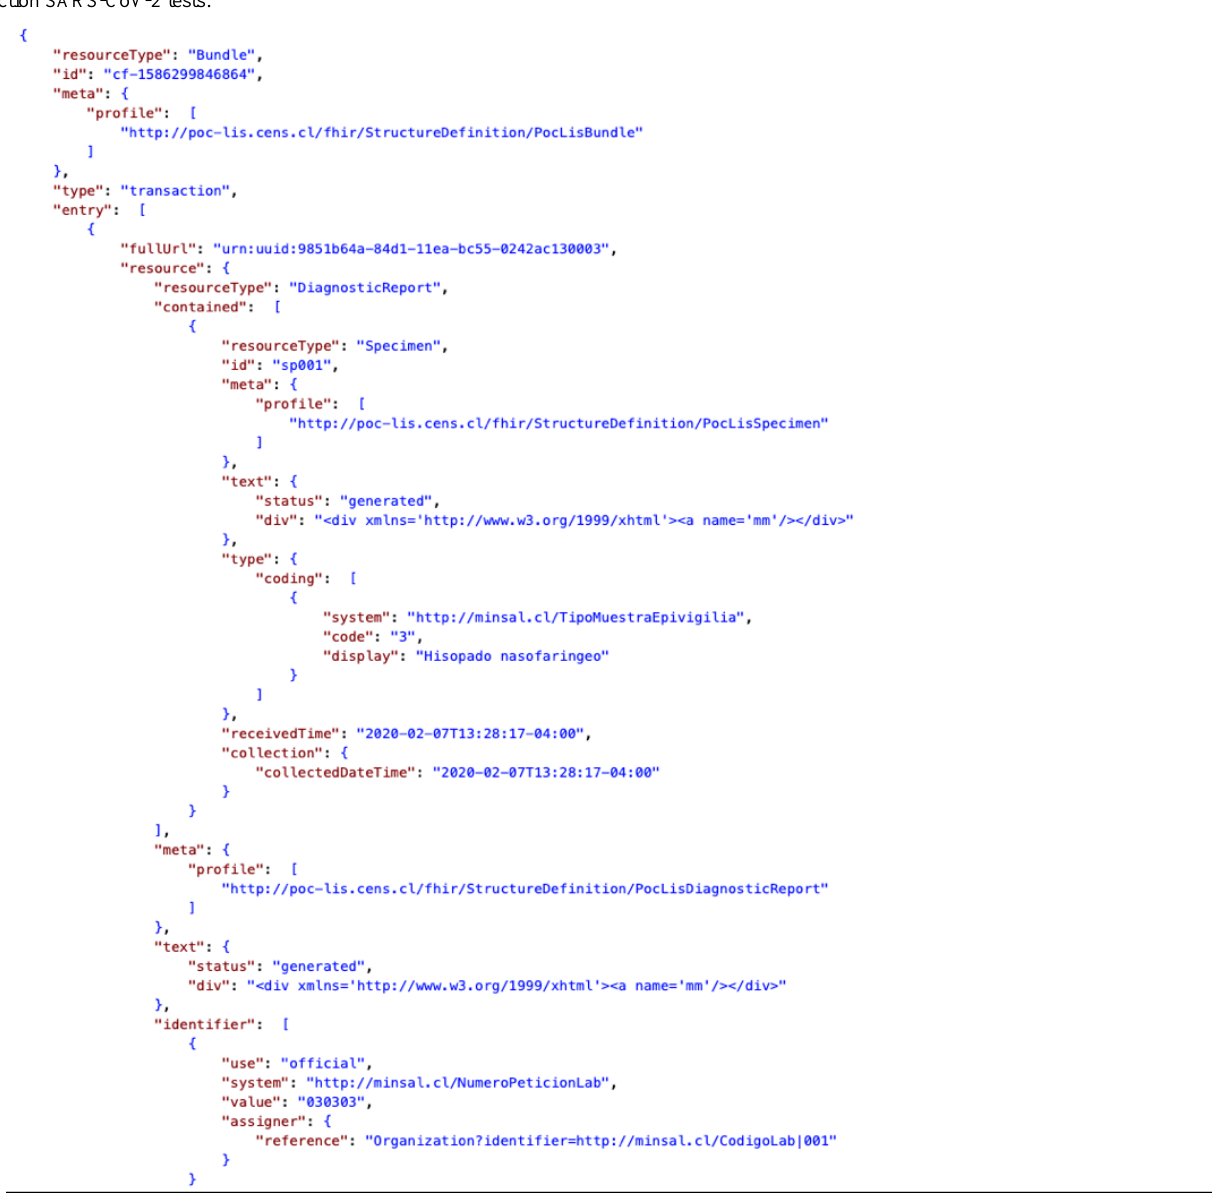
Figure 7. Fast Healthcare Interoperability Resources Bundle (part of the complete Bundle) that contains the resources selected for polymerase chain reaction SARS-CoV-2